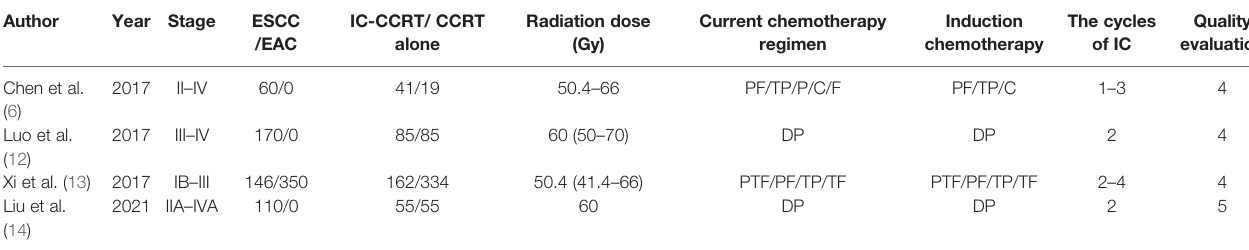
TABLE 1 | Basic characteristics of the included studies (IC-CCRT vs . CCRT alone